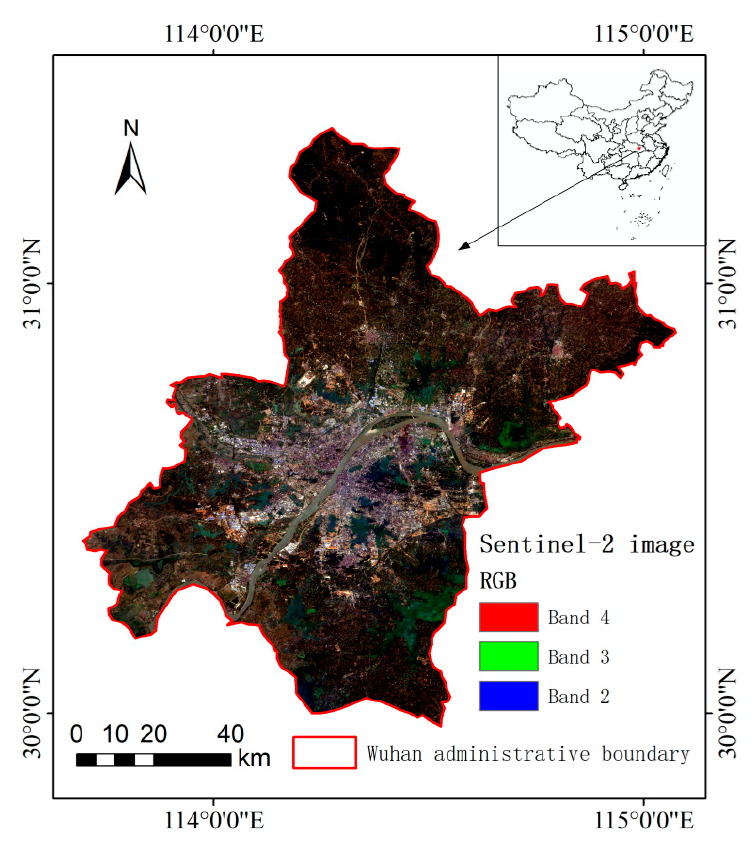
Figure 1. The study area of Wuhan.